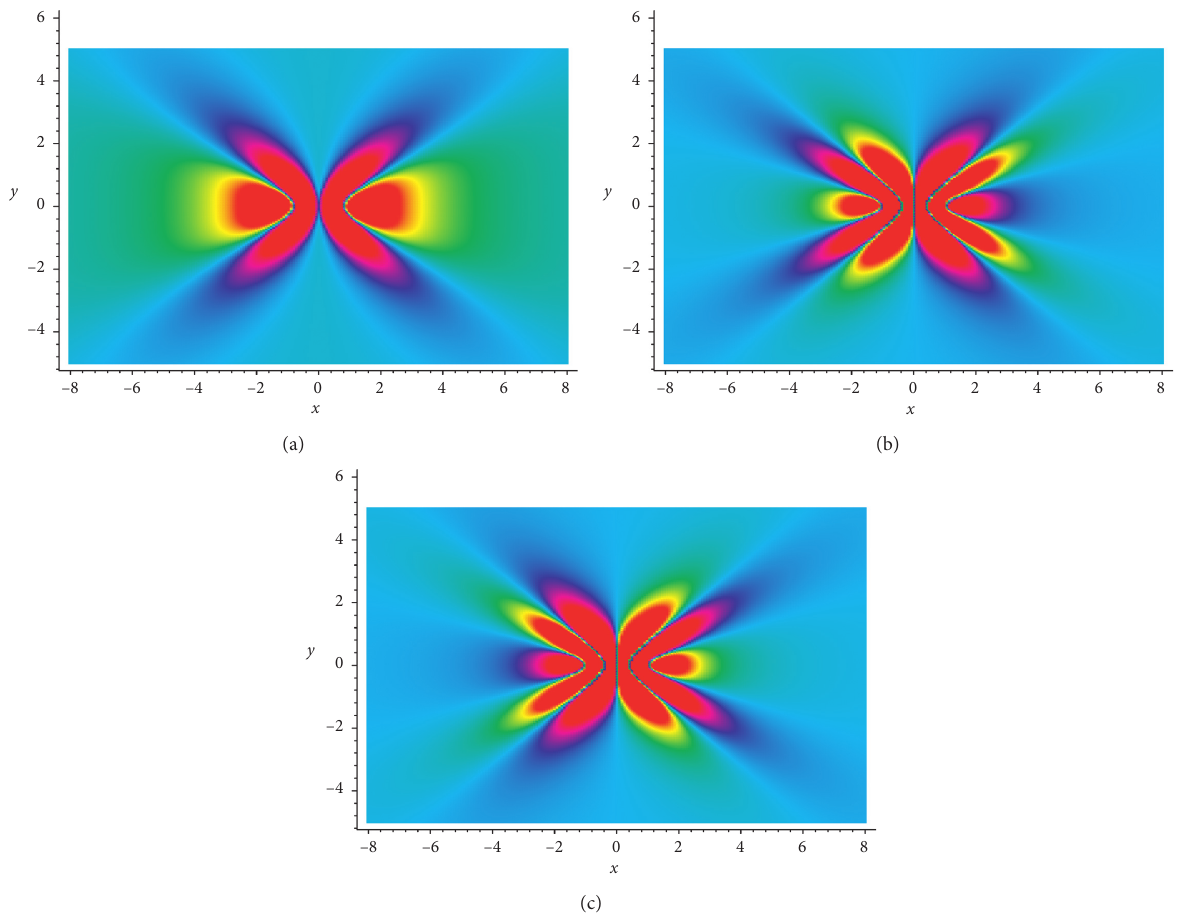
Figure 8: The symmetry breaking density plot of the second-order lumps of the AB-KP systems (7a) and (7b), with the selected parameters b � b � 0 and (b) and (c) b and b are (a) b 1 2 1 2